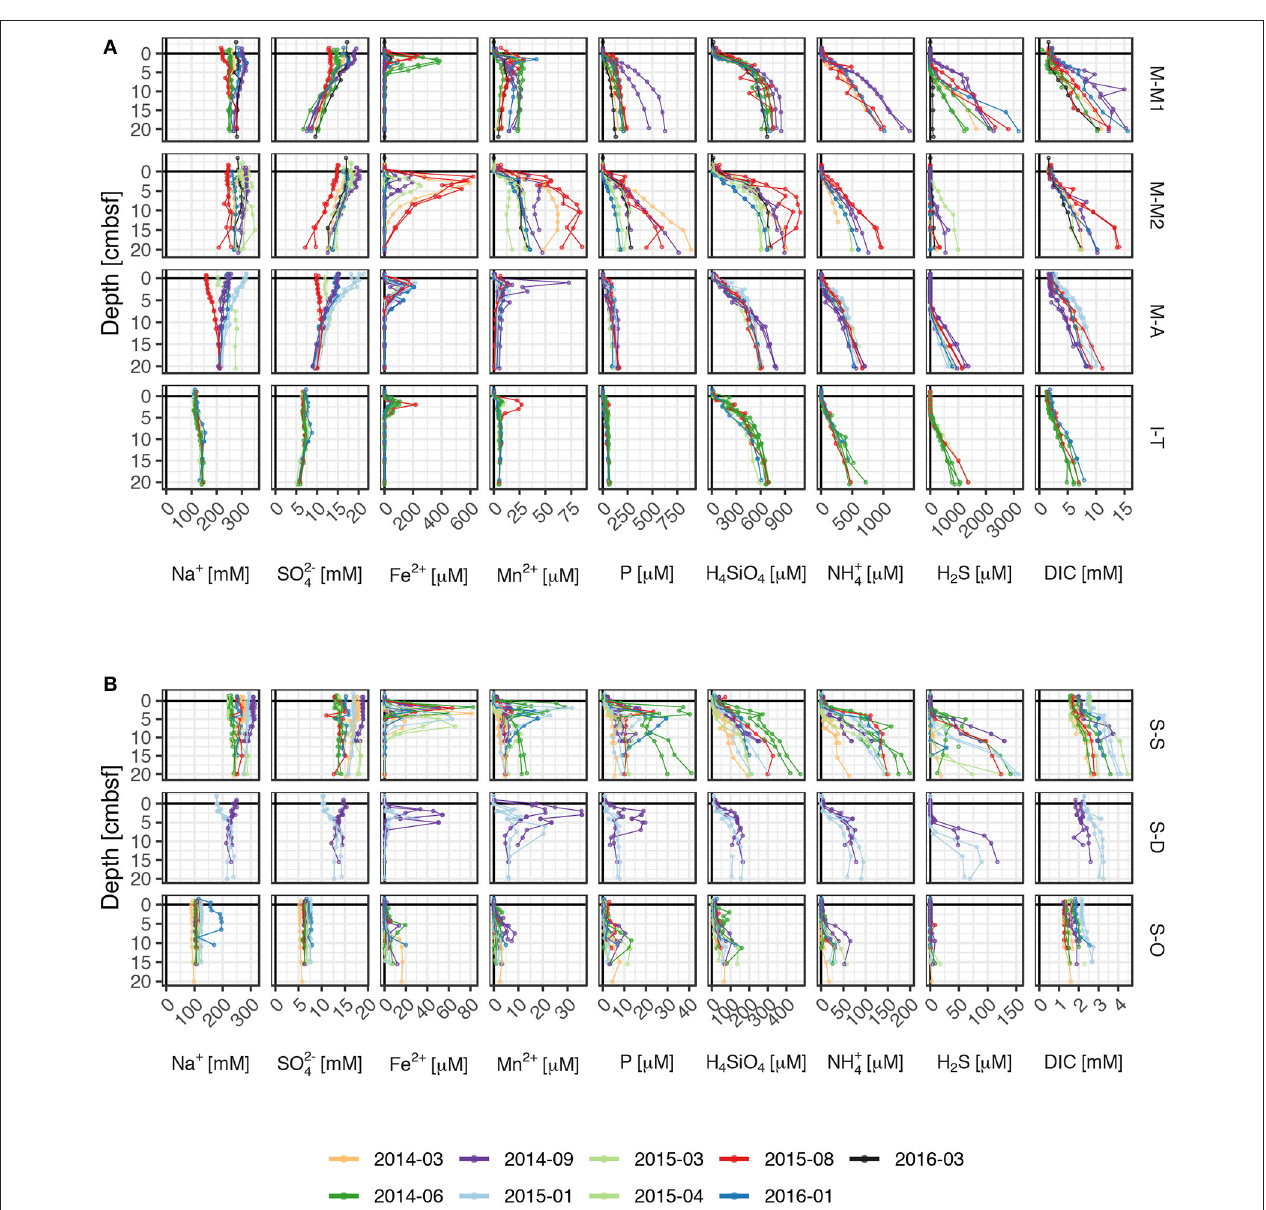
FIGURE 6 | Multi-parameter pore water concentration profiles in (A) soft sediments and (B) sandy